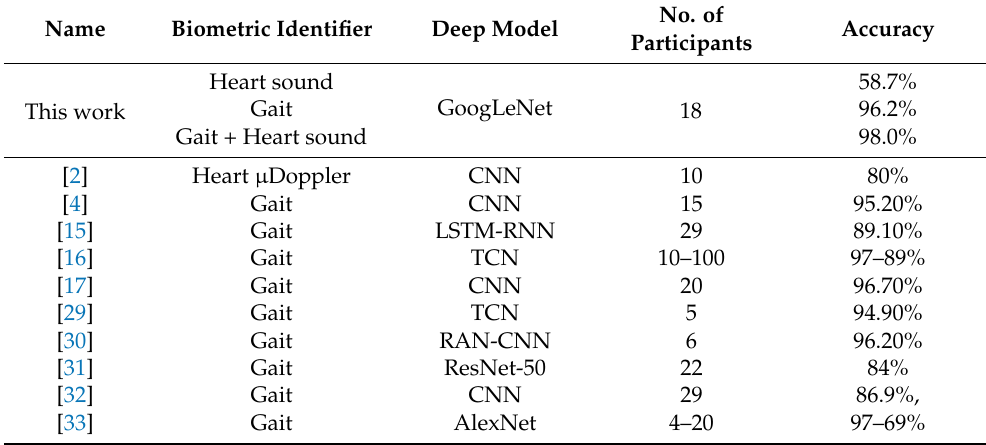
Table 6. Summary of the achieved identification accuracy results compared to